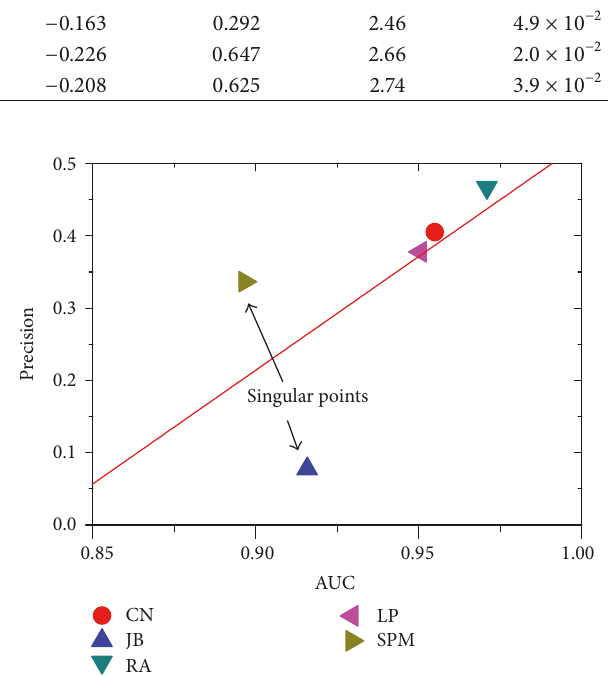
Figure 2: AUC and precision of the USair network obtained by five different approaches: common neighbors (CN), Jaccard index (JB), resource allocation index (RA), local path index (LP), and structural perturbation method (SPM). The results are obtained by 50 independent simulations. SPM method achieves high precision, yet low AUC, and JB has low precision, but high AUC ( >